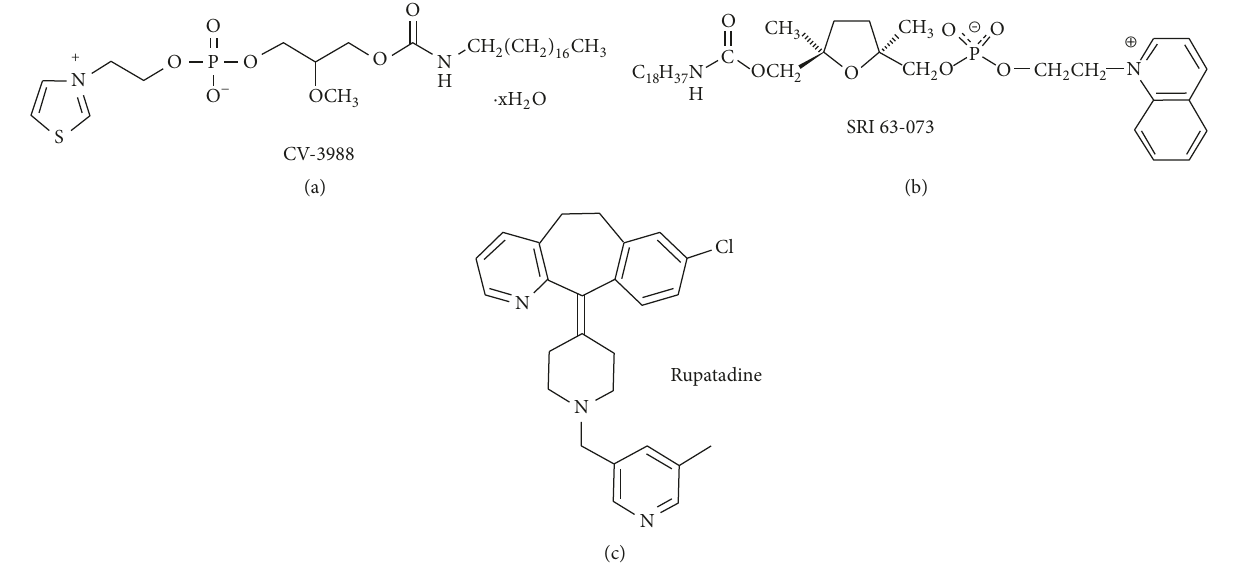
Figure 3: Synthetic PAF